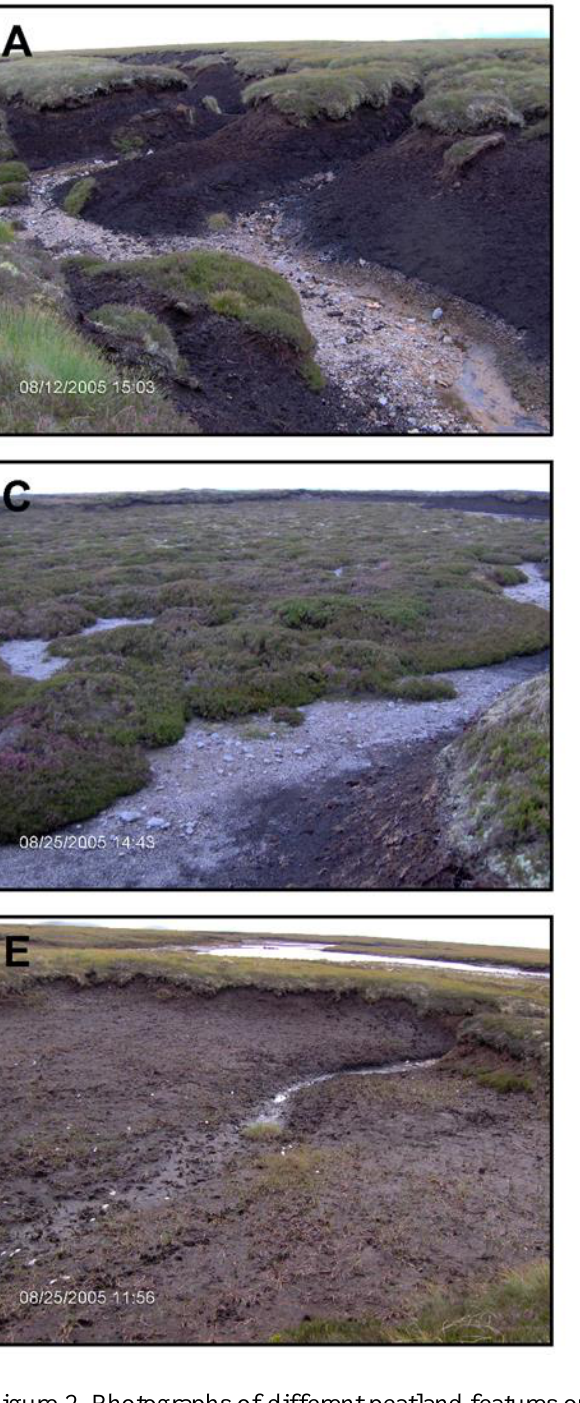
Figure 2. Photographs of different peatland features on the study site, taken during field surveys in August 2005. A: an example of a hagged area. B: a nearly empty pool, with extensive bare peat and patches of Eriophorum angustifolium . C: a pool apparently empty for many years, with some mineral soil and extensive Calluna vulgaris . D: An intact strip of land between two pools, showing the apparent development of a channel between the pools (foreground), marked by deer trampling. E: an empty pool, draining into a lower pool via a clear channel. F: a hole in the bed of an empty pool, apparently connecting to subterranean drainage such as a peat